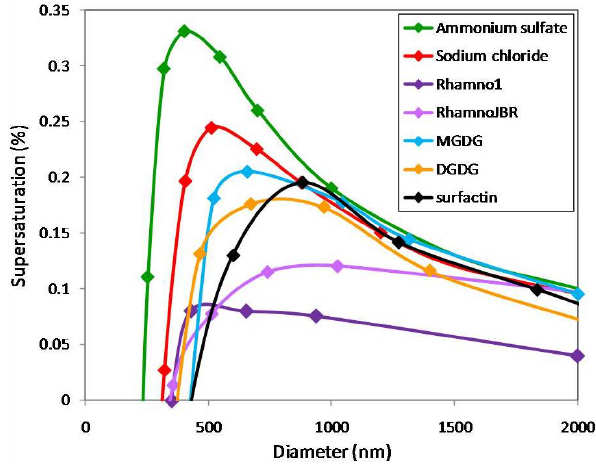
Fig. 2. K¨ohler curves for inorganic salts and standard microbial sur- factants in aqueous solutions of sodium chloride 0.07–0.2M (dry diameter=60nm). sodium chloride: red; ammonium sulfate: green; monogalactosyl diacylglyceride (“MGDG”): pale blue; digalactosyl diacylglyceride (“DGDG”): orange; surfactin: black; rhamnolipid (extract 1, “Rhamno1”): dark purple (this curve with ammonium sulfate instead of sodium chloride); rhamnolipid (extract 2, “Rham- noJBR”): pale purple.